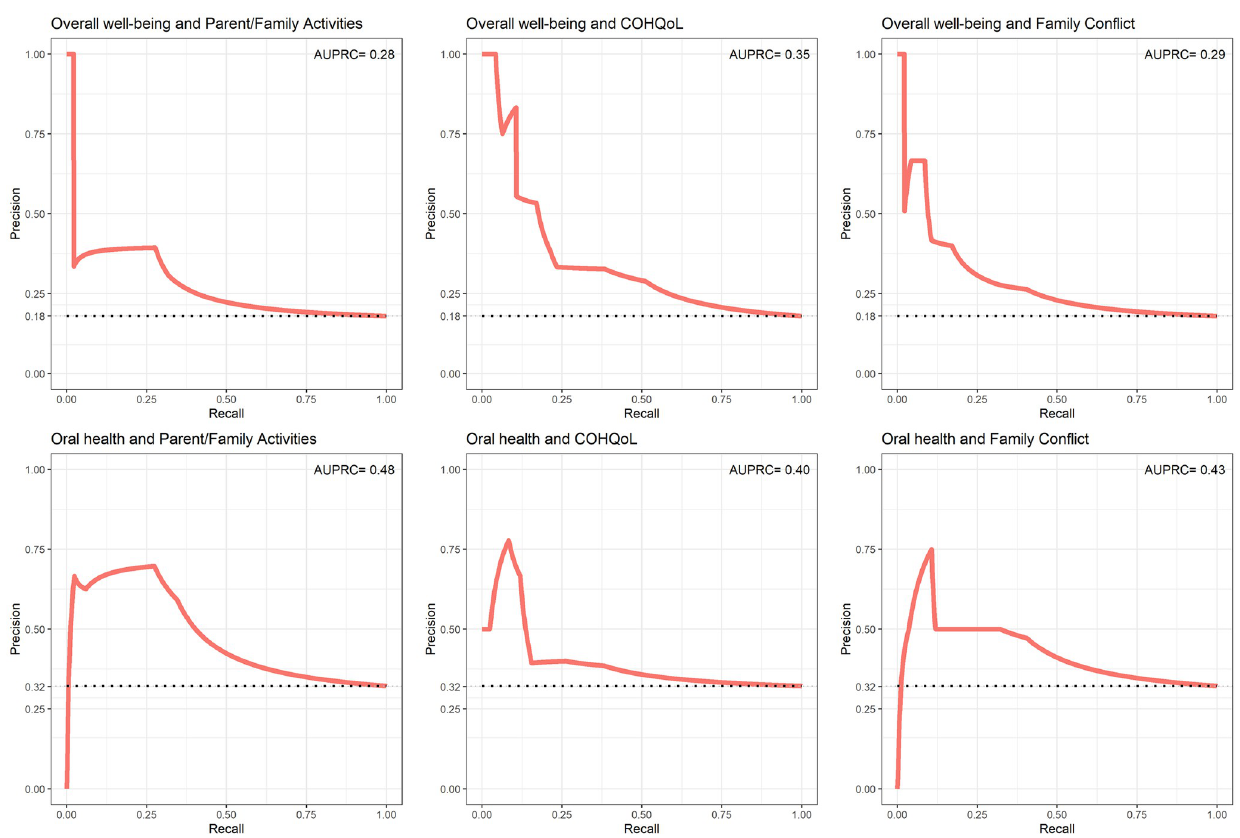
Fig 4. Precision-recall curves between P-CPQ/FIS dimensions and overall well-being/oral health. Note. The y-axis indicates the Precision (i.e. positive predictive value). The x-axis indicates the Recall (i.e. sensitivity). The black dotted line is the prevalence of the outcome in the population (e.g. prevalence of poor overall well-being). The continuous red line is the Precision-Recall Curve (PRC), indicating the precision value according to each recall value. The AUPRC is reported on the top